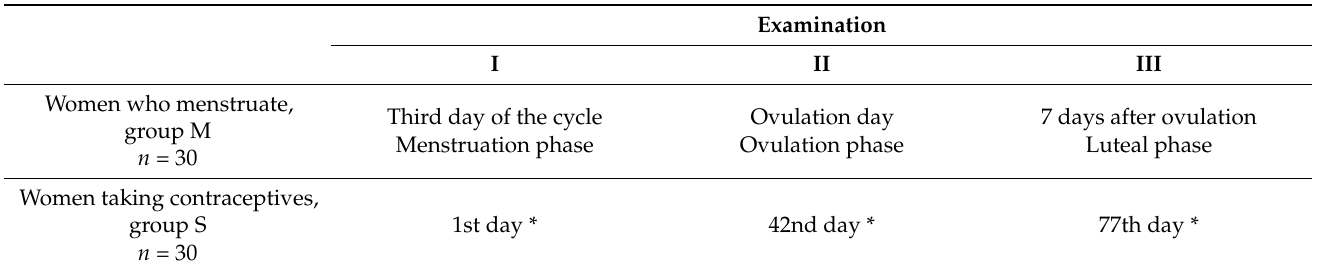
Table 1. Composition of the study material and timing of the